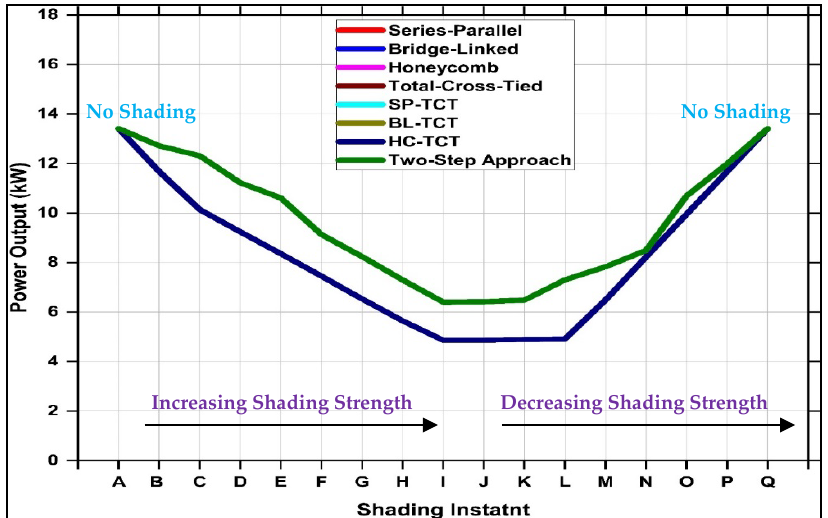
Figure 20. Power output comparison of 18 × 3 array for partial shading cases.